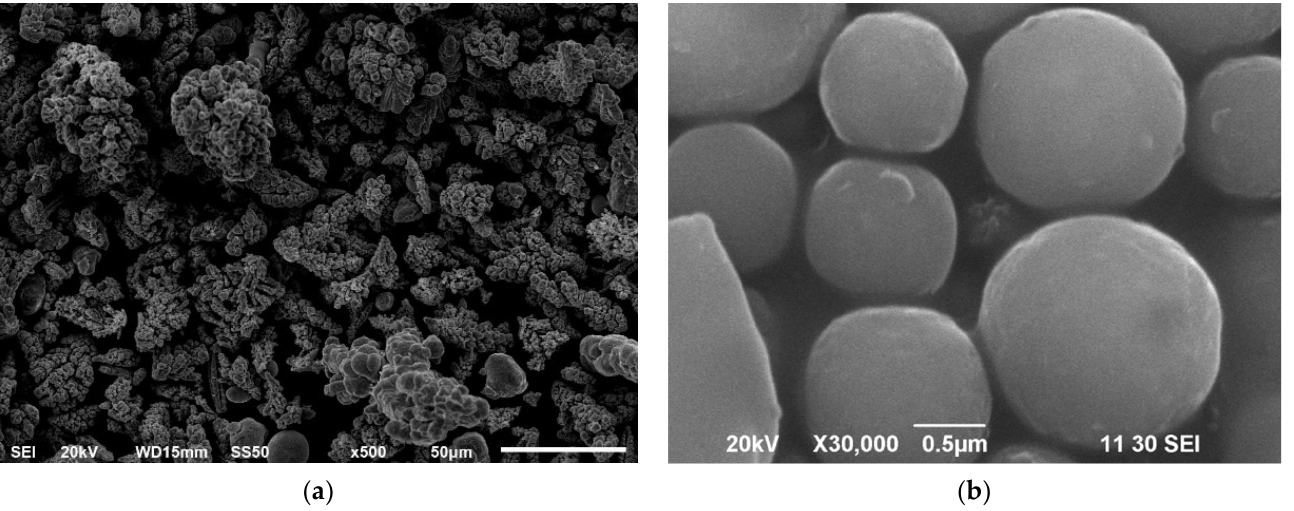
Figure 1. Morphology of matrix and reinforcement particles: ( a ) morphology of copper powder; ( b ) morphology of fly ash particles.